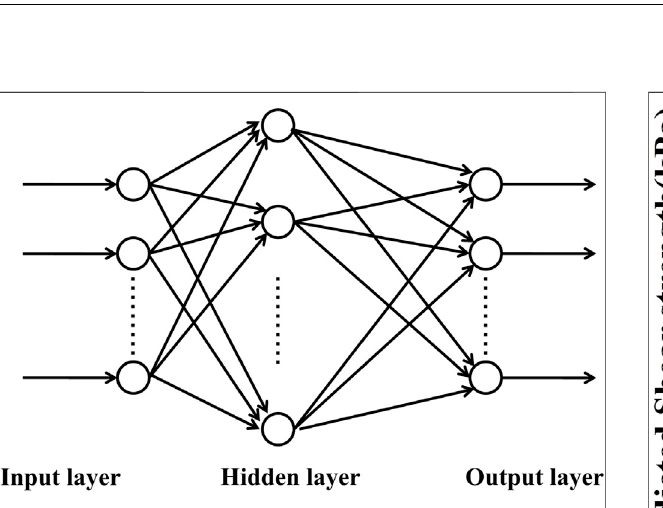
FIGURE 11 | Schematic diagram of the BP neural network model.